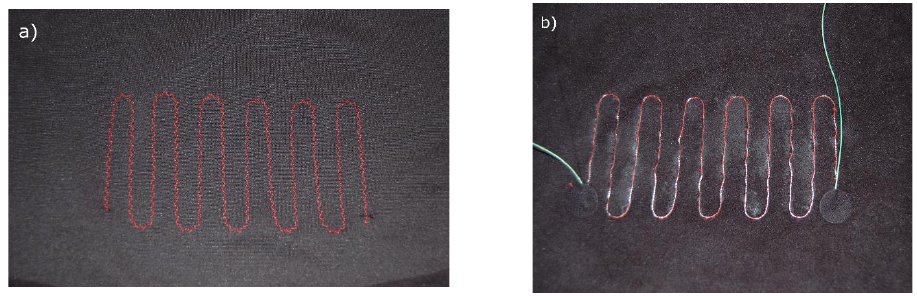
Figure 7. Photographs of the heating insert (variant A) after 9000 cycles of bending and twisting — outer surface ( a ) and inner surface ( b ).